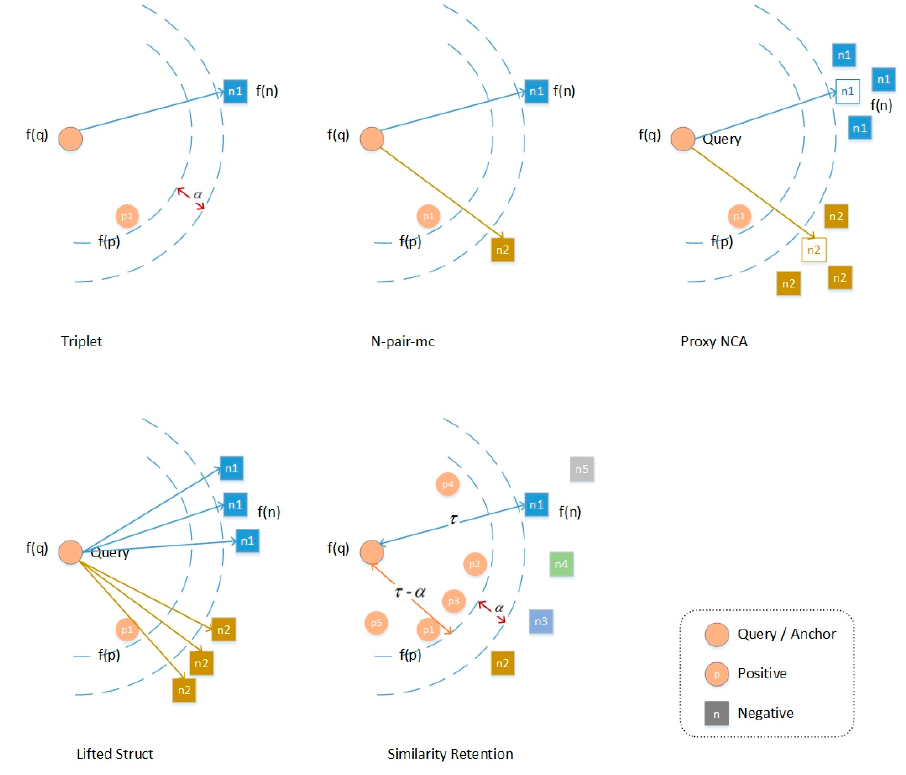
ff erent ranking-motivated losses and our Figure 2. The illustration and comparison of different ranking-motivated losses and our method. Figure 2. The illustration and comparison of di